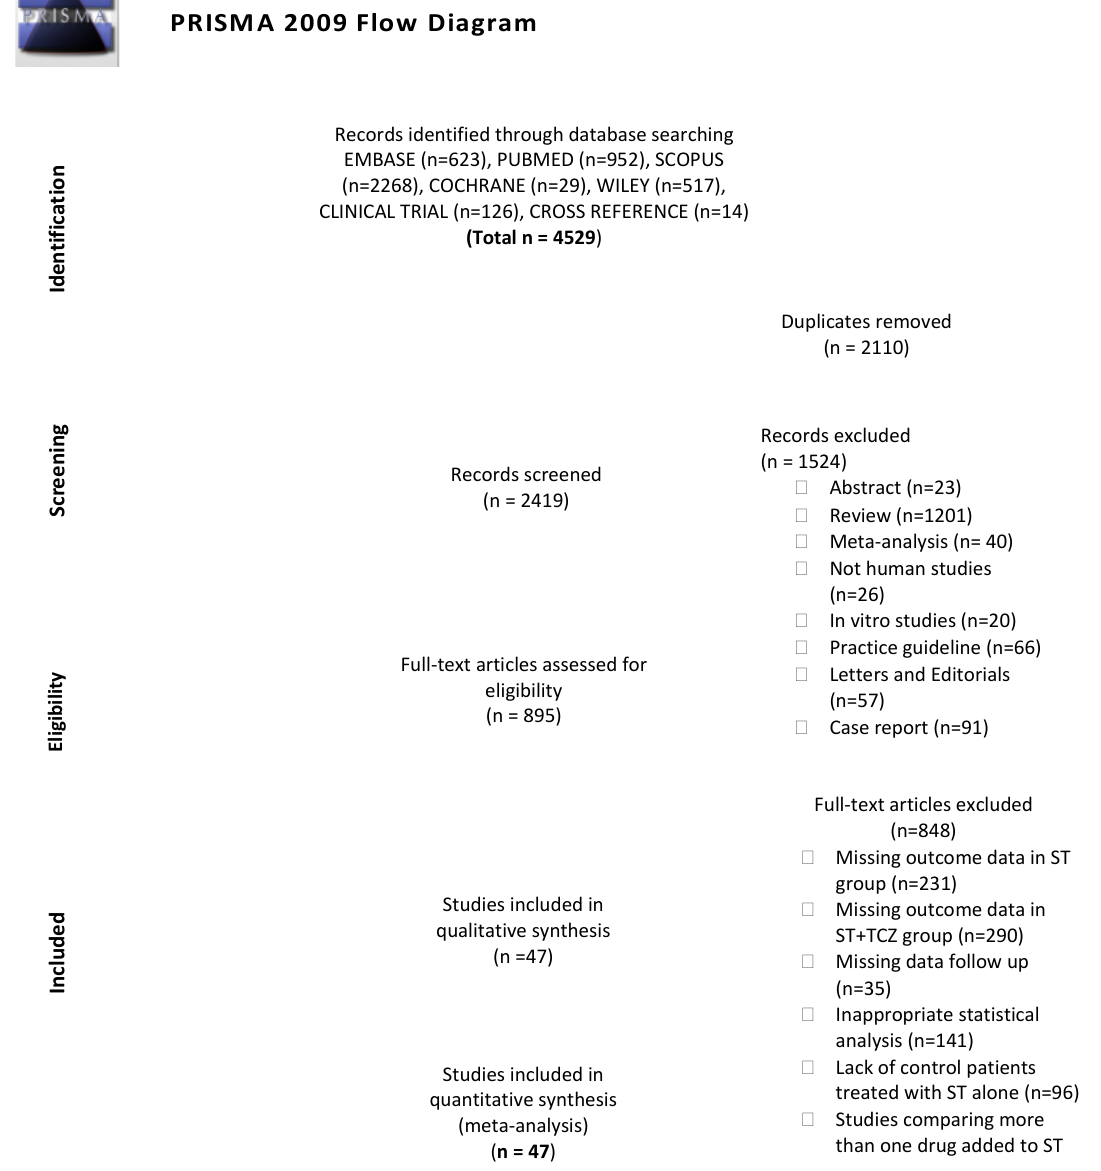
Figure 1. The PRISMA algorithm of the study.